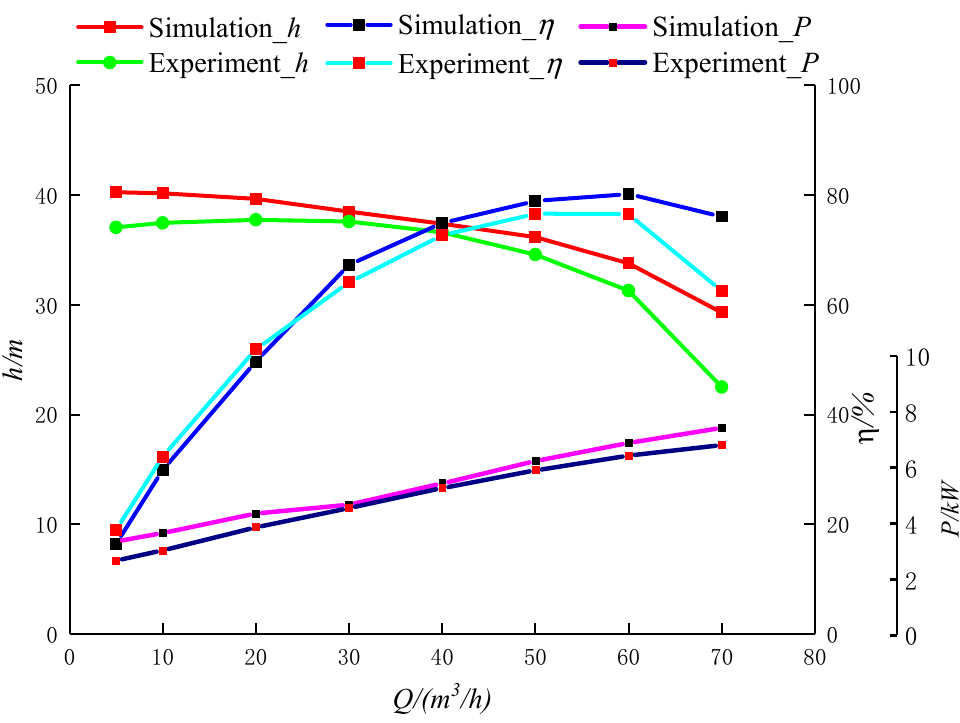
Figure 6. Comparison of test and numerical results.